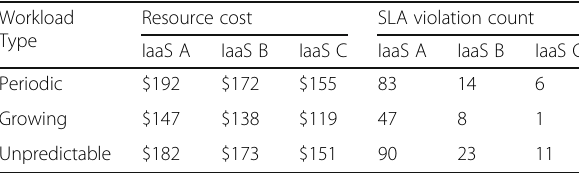
Table 2 The cost factor values for the different VM boot-up times (iteration 1 – no database